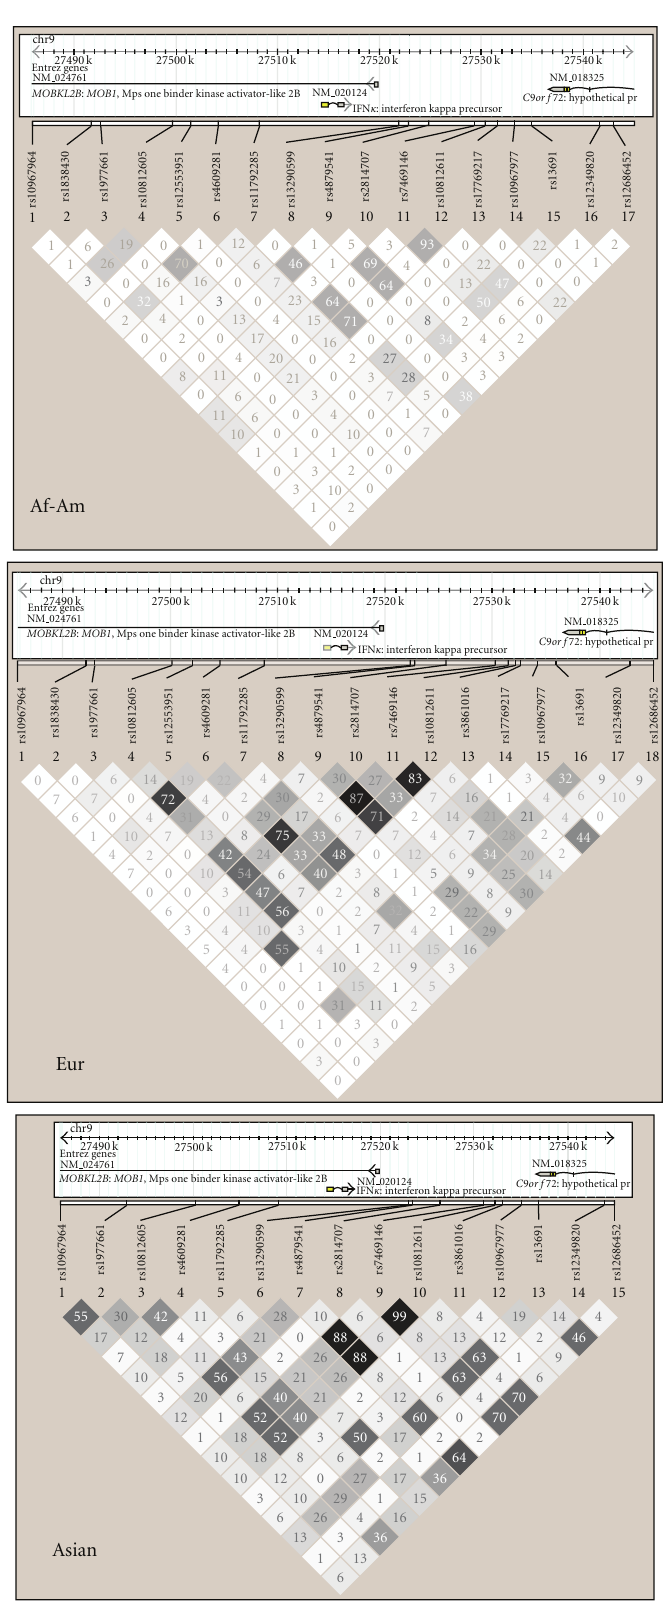
Figure 1: Haplotype diagrams showing LD structure between SNPs near the IFNK gene in each ancestral background. Generated using Haploview 4.1 software, the plots show pairwise comparisons between each SNP in each ancestral background as r -squared values. Increased dark shading indicates higher r -squared values between the two SNPs. Eur.European ancestry, Af-Am.African-American